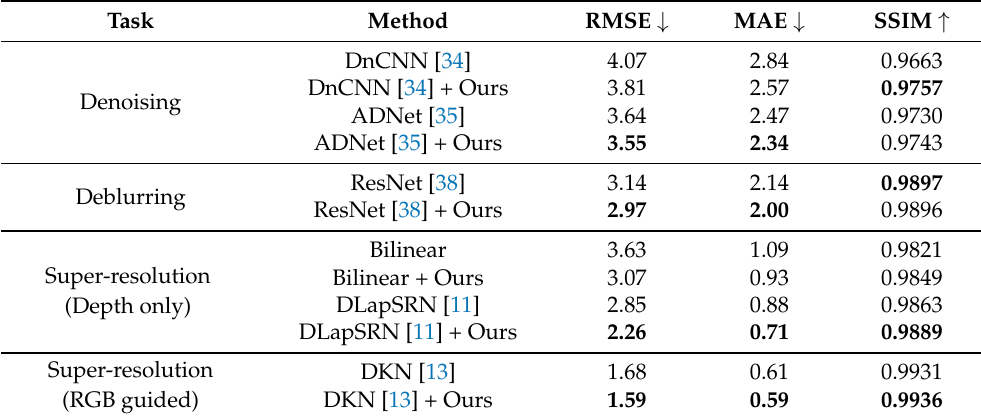
Table 2. Quantitative comparison of depth-map reconstruction for different tasks on the NYU v2 dataset [33]. Values are given in centimeters (RMSE and MAE) and averaged over all test set images.